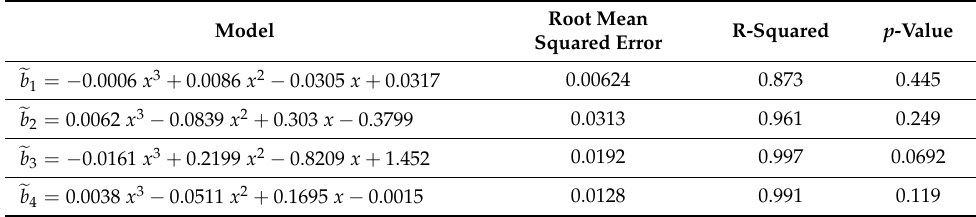
Table 15. Parameters’ models and statistics (procedure 4).